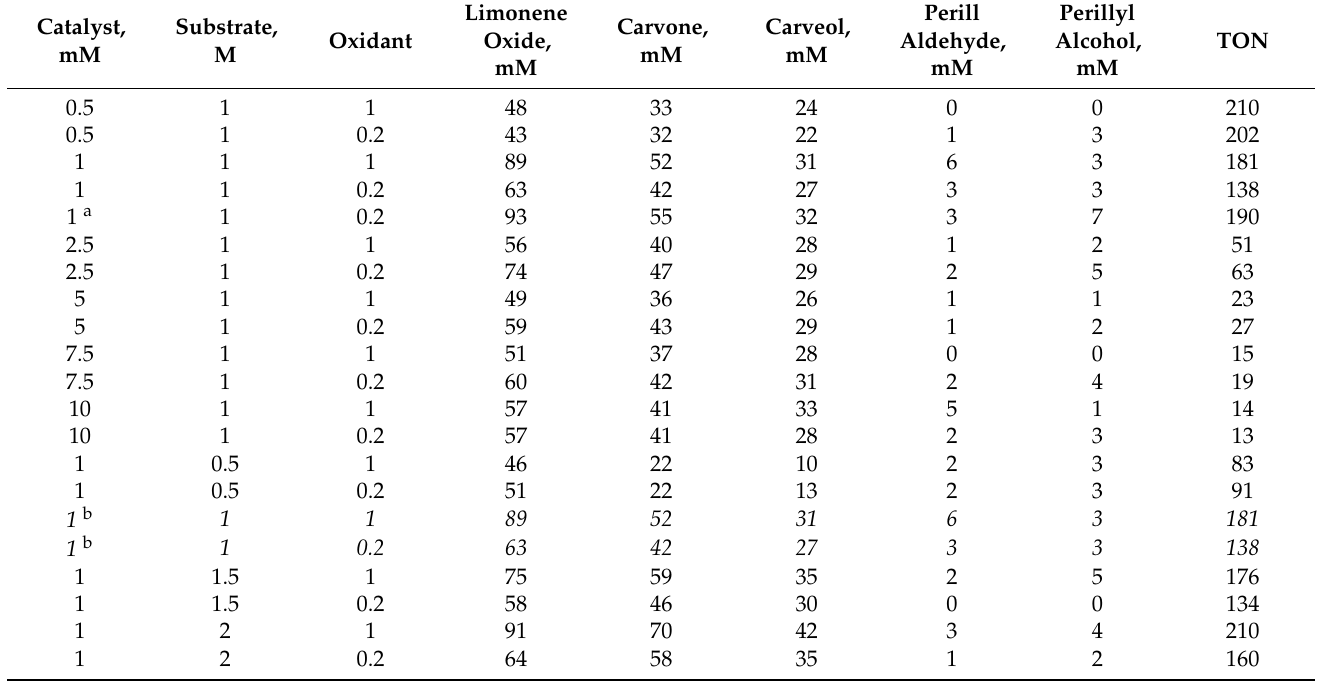
Table 2. Oxidation of limonene with dioxygen (p O2 = 1 atm) and air (p O2 = 0.2 atm) catalyzed by [(N4Py)Fe II ] 2+ in MeCN. Reaction time 24 h.